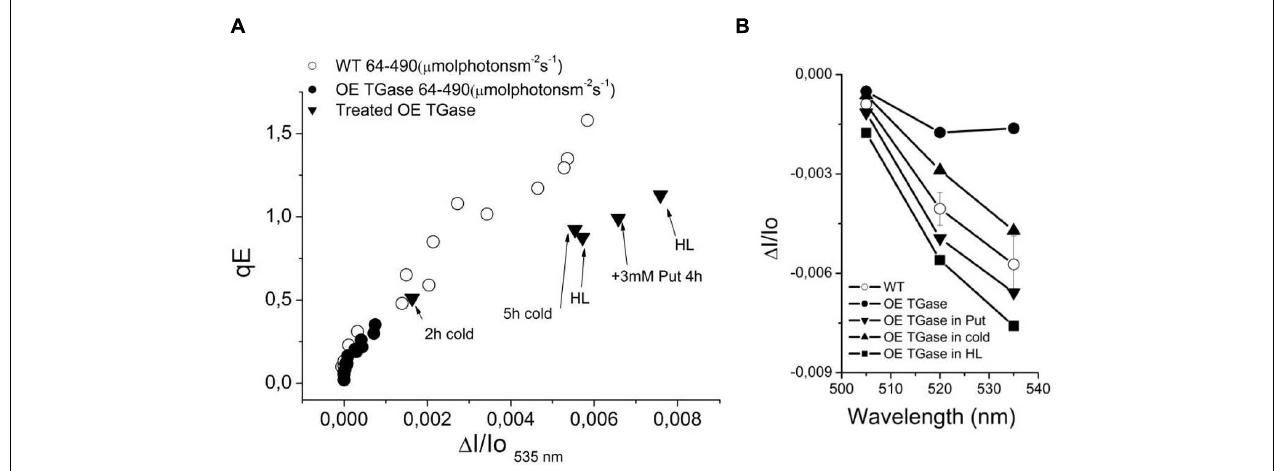
FIGURE 8 | The phenomenology of antenna down regulation. (A) qE is linearly dependent on 535 nm signal. In OE TGase the signal at 535 nm is of very low amplitude (for the standard experimental conditions that used intensities from 64 up to 490 µ mol photons m − 2 s − 1 ). The signal gets higher upon treatment with cold (see values for 2 and 5 h cold), with putrescine free base (see value for 3 mM Put) or exposure to 10-fold higher light than growth intensity (see values for HL). (B) The spectra of selected treatments (from 505 to 535 nm). The purpose of the treatments in OE TGase is to provide additional data pairs (for example in panel A qE and (cid:49) I/Io 535 nm values) for a broader range than the standard experiment. For example the standard experiment (64–490 µ mol photons m − 2 s − 1 ) for OE TGase signal at 535 nm covers a range from 0 to 1 mAU unit, whereas by adding data from the different treatments one expands the range up to 8 mAU. For the WT the range is large enough and there is no need to introduce more data